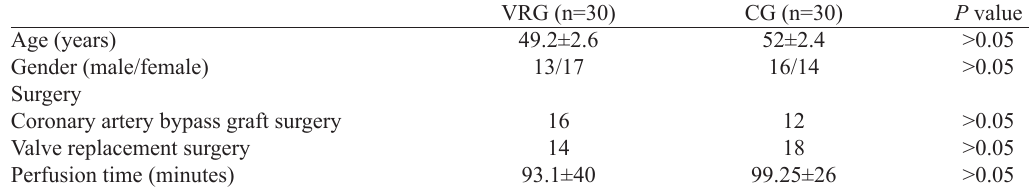
Table 1. CG - Control Group, VRG - Virtual Reality Group. Data were analyzed using the X 2 test. P > 0.5 - no statistically significant.